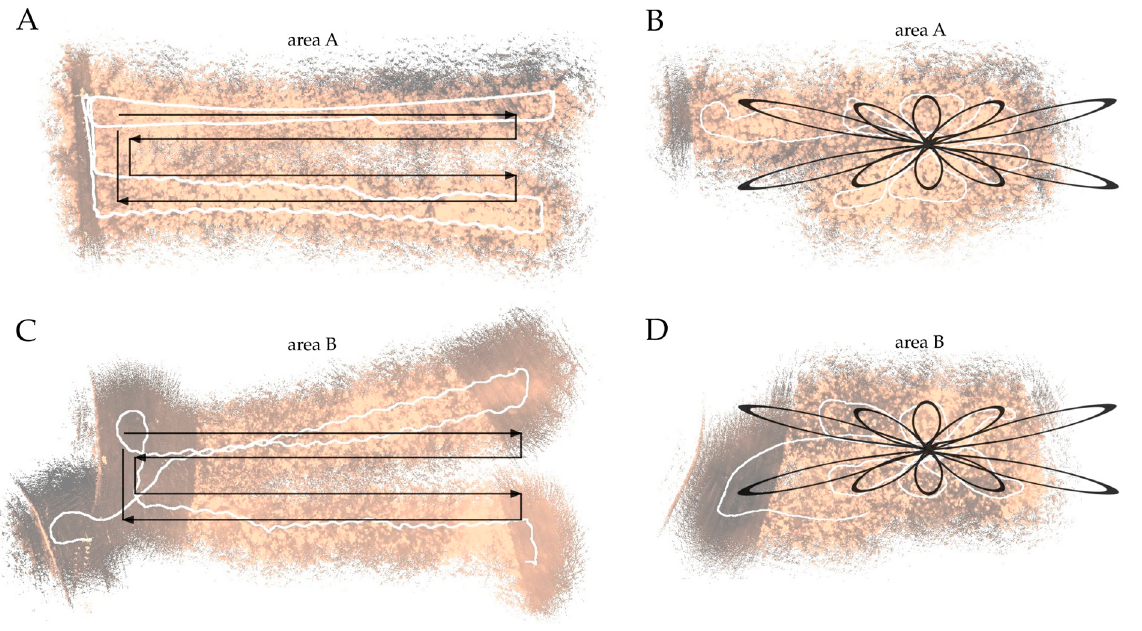
Figure 5. Results of the zigzag ( A , C ) and looped ( B , D ) walking trajectories (in black: planned trajectories, in white: recorded trajectories). The point cloud backdrop images show variation in low to high point densities (grey to colored) and the influence of point cloud drift. The corresponding RMS are 1.58 ( A ), 1.48 ( B ), 3.12 ( C ), 2.89 ( D ).